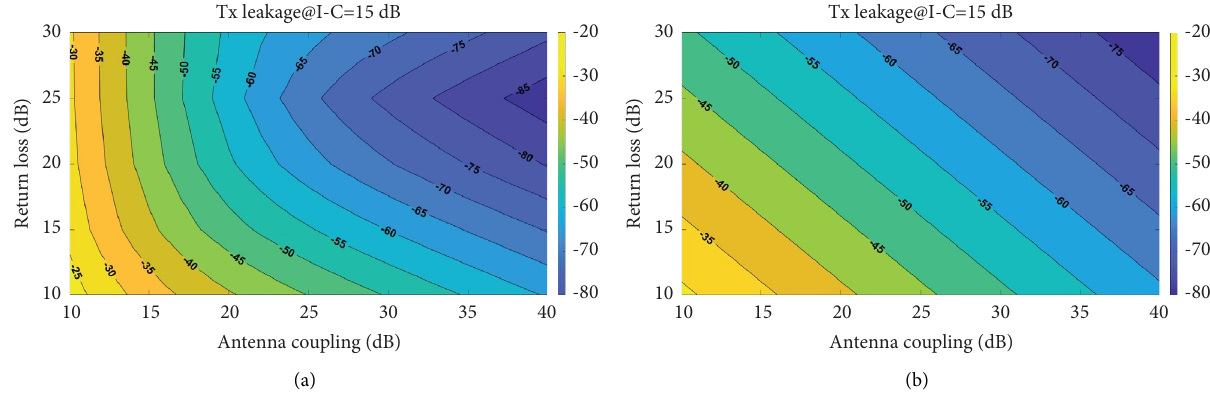
Figure 6: Tx leakage levels against the antenna coupling and return loss of the Tx and Rx antennas with I − C � 15dB from (a) equation (7) and (b) equation (11).